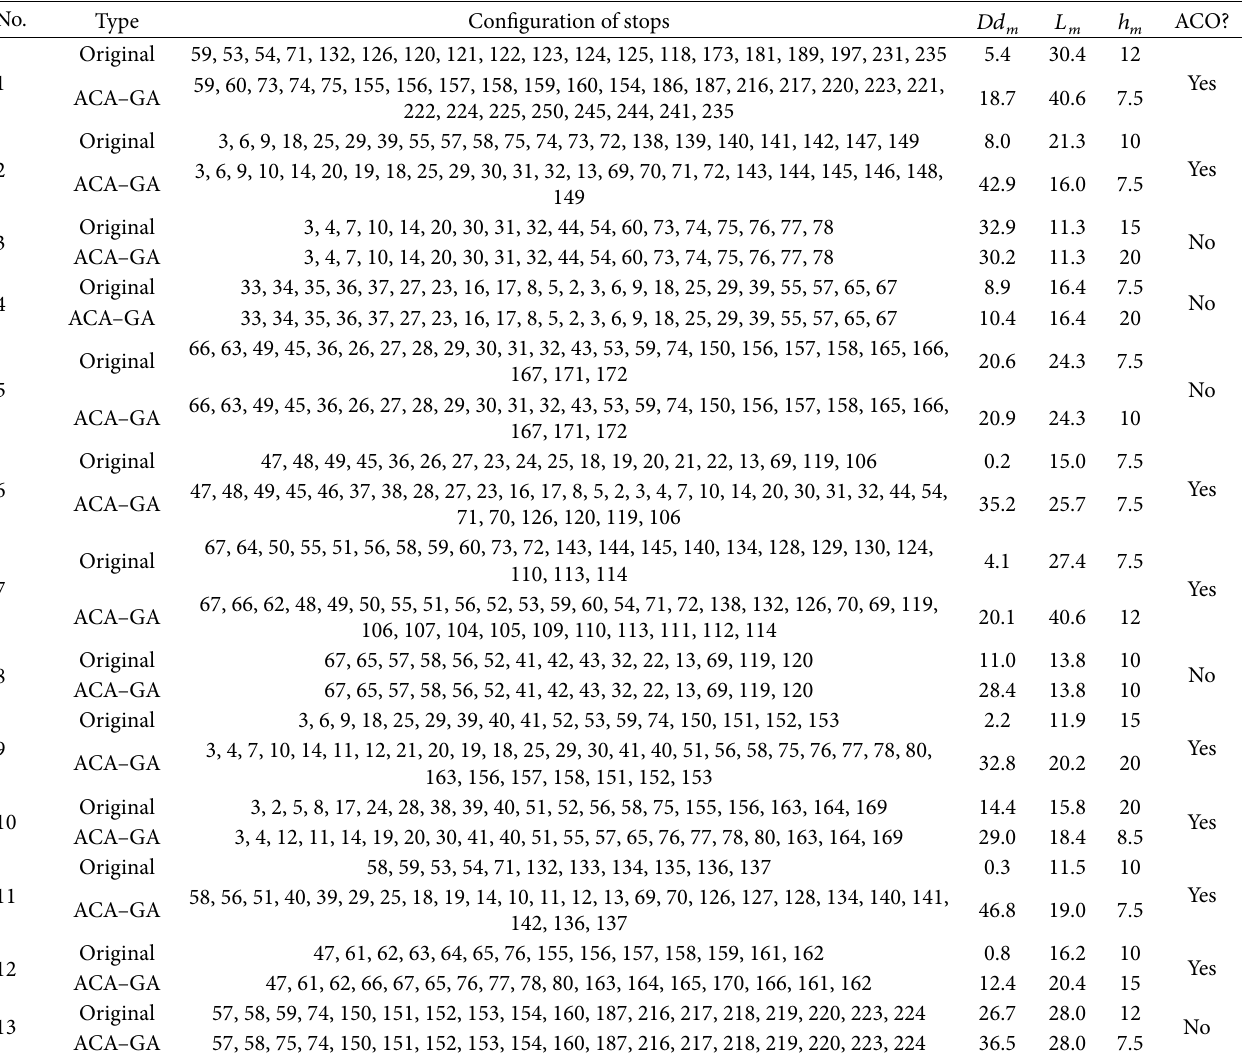
Table 2: Results of original and ACA–GA